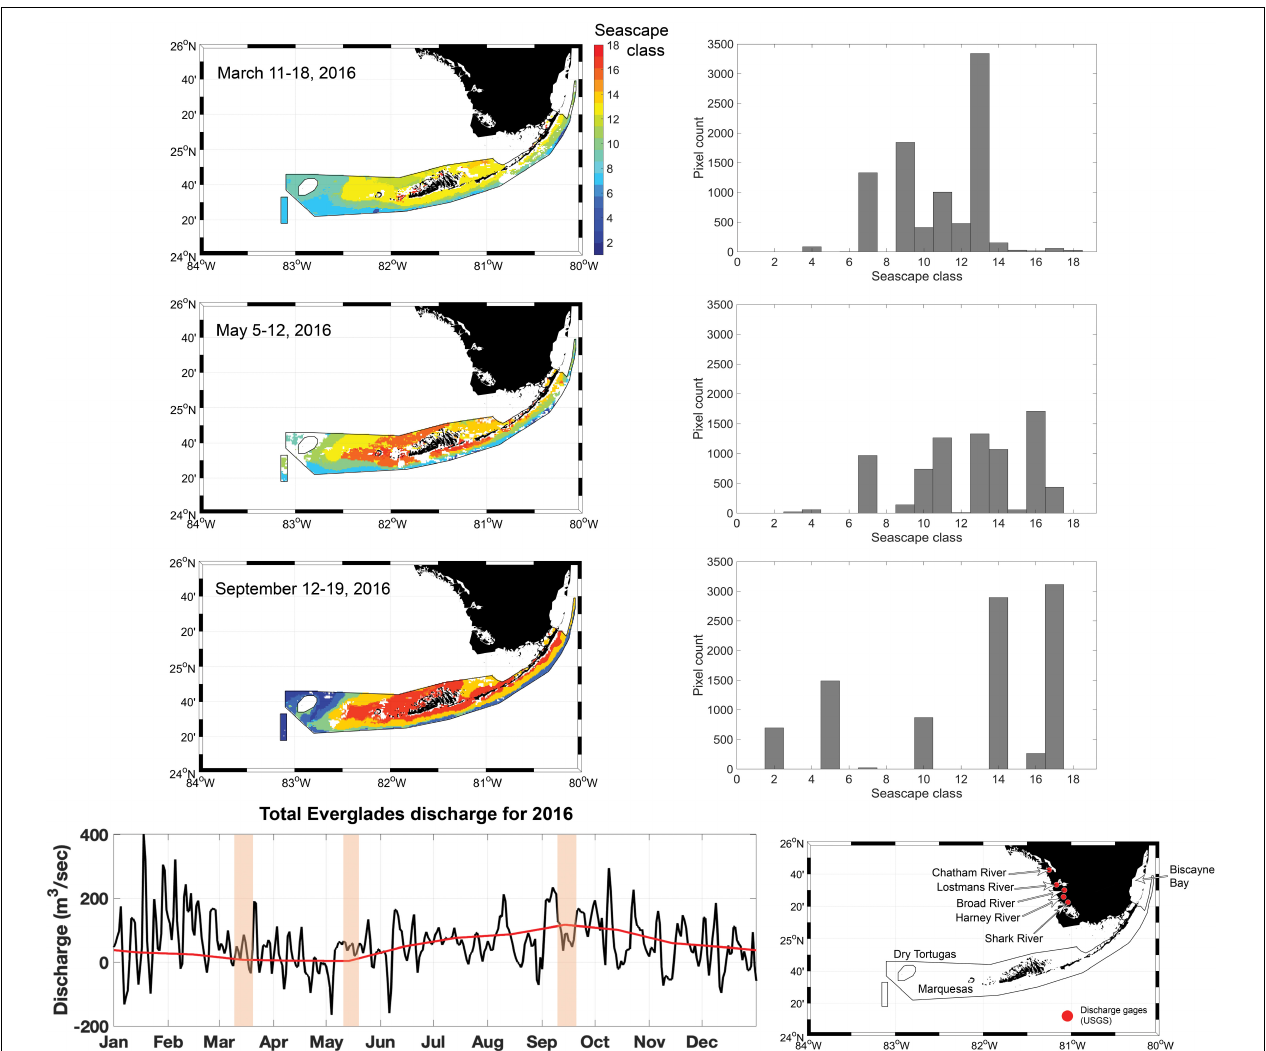
FIGURE 8 | Eight-day composite seascape maps within the FKNMS boundaries only (left) during the three cruise periods ( top to bottom ). Bar plots show pixel counts of each seascape class extracted from corresponding maps. The time series plot at the bottom shows average daily discharge for 2016 (black line) based on flow data collected at five discharge gages managed by the U.S. Geological Survey (shown in adjacent map). The red line shows the discharge climatology (1997–2018). Shaded bars highlight the sampling period of each